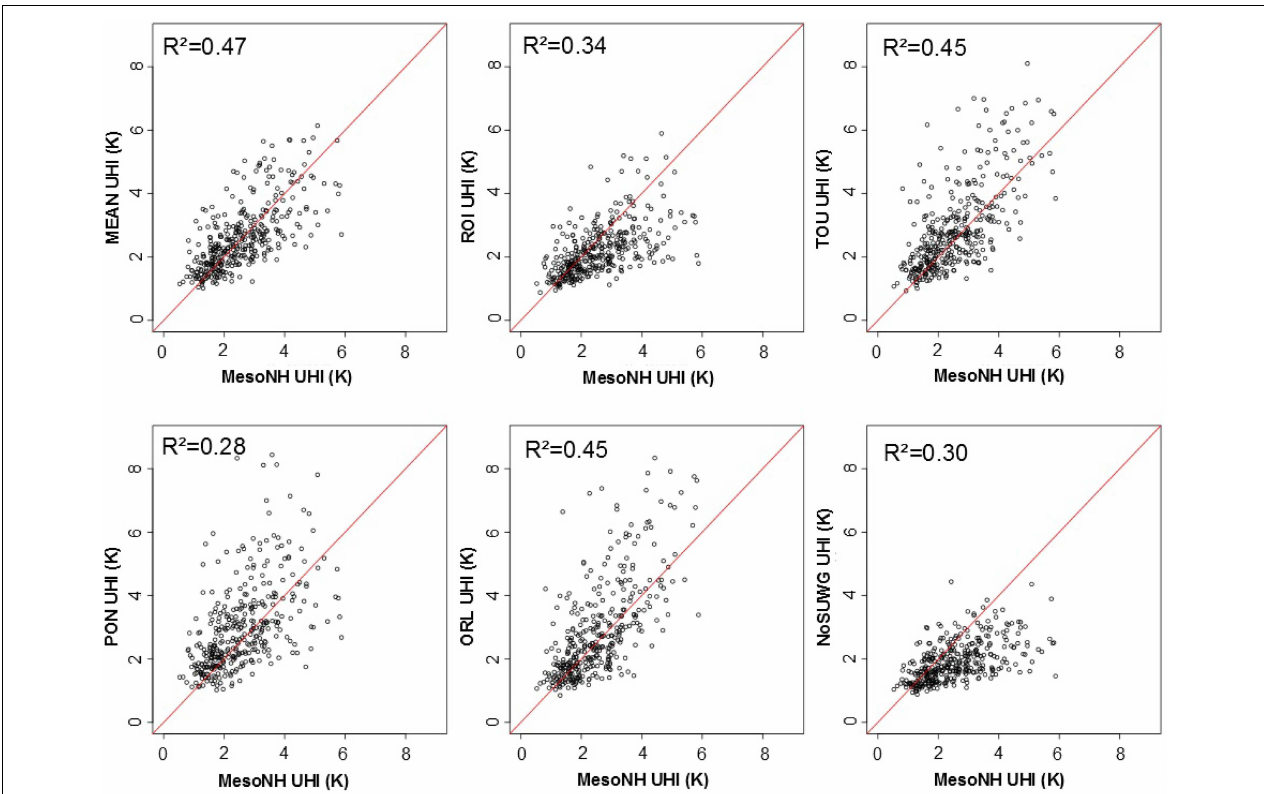
FIGURE 6 | Comparison between simulation with the SUWG and MesoNH for the Paris UHI at 2m at 3:00 UTC over a year for each forcing points and without the SUWG (NoSUWG).